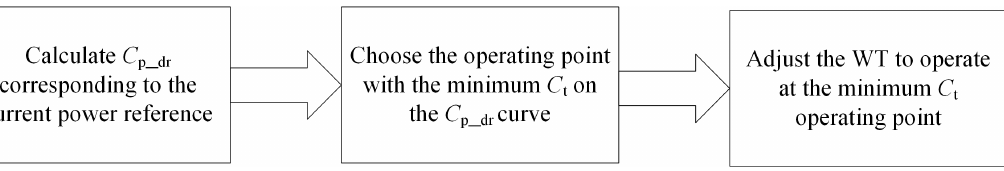
Figure 4. Process of the Min- C t